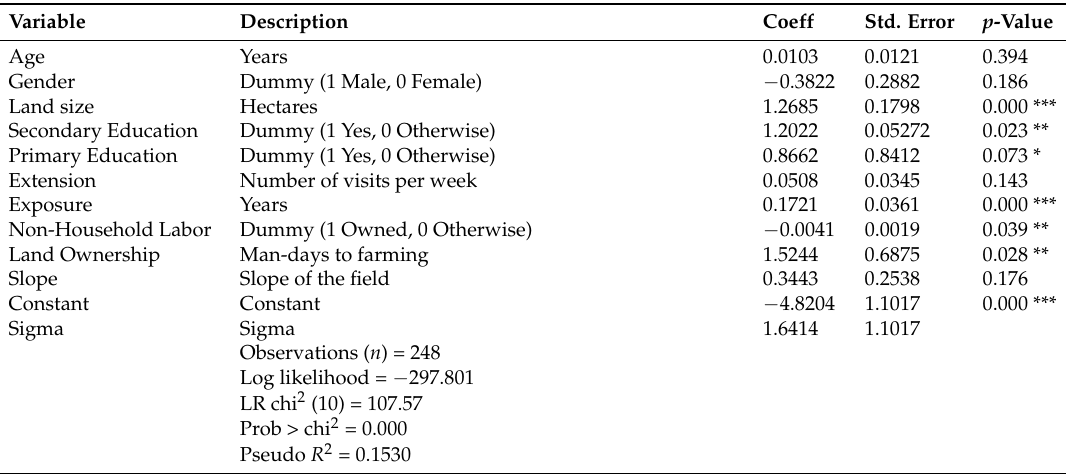
Table 5. Determinants of household decisions to adopt fertilizer trees and